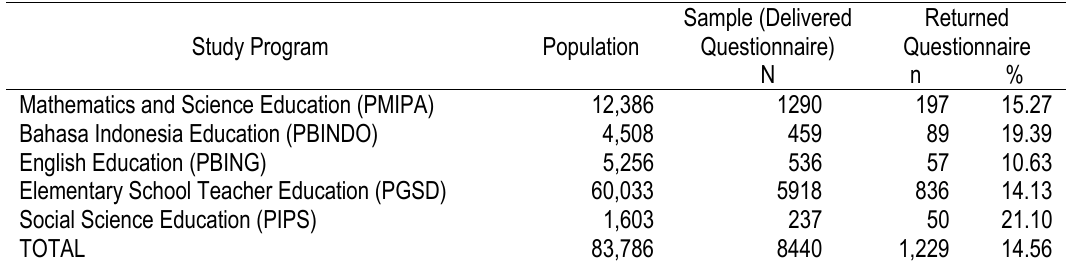
Table 1. Number of Population and